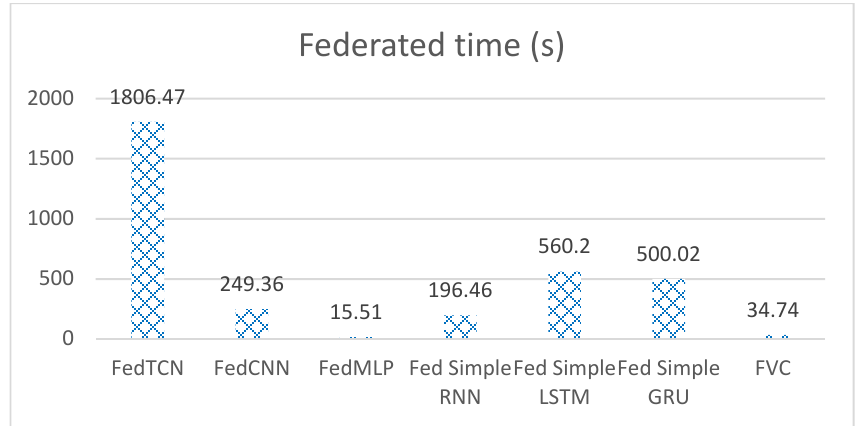
Figure 9. Federated time comparison of FVC with previous research.